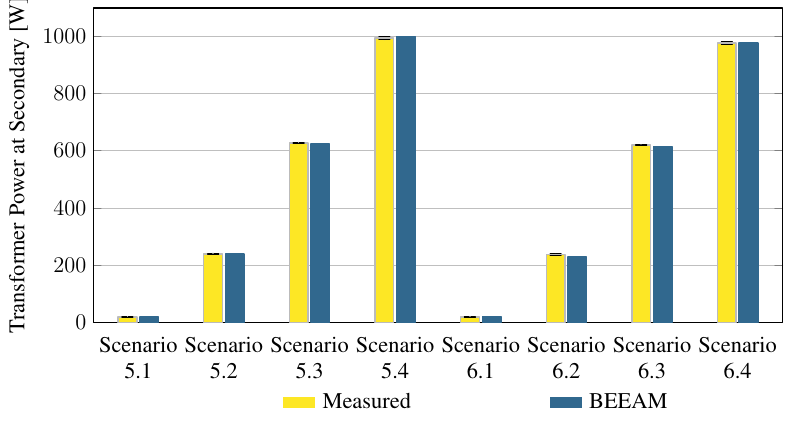
Figure A13. Predicted versus measured transformer power, secondary; Scenarios 5 and 6.